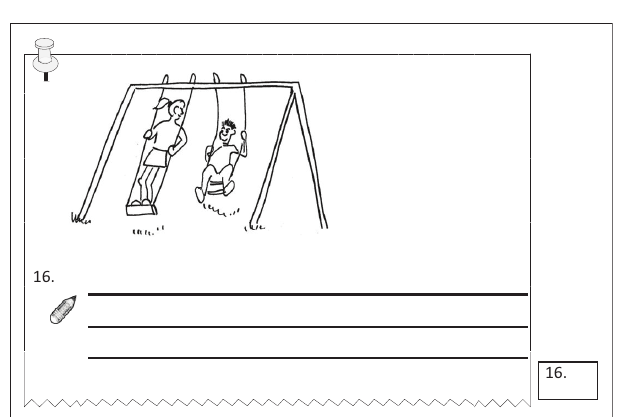
16. FIGURE 1-A2: ‘Write a sentence’ item: The caption for the question read: ‘Look at the pictures in questions 16 – 18. For each picture write a complete sentence about what the child or children are doing in the picture’.